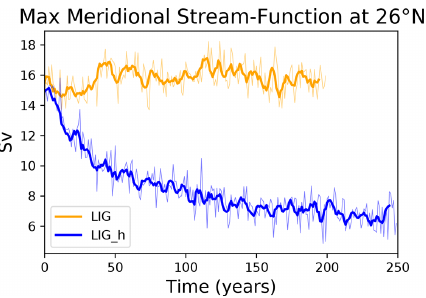
Figure 1. Maximum meridional streamfunction at 26 ◦ N for LIG (orange) and LIG_hosing (blue). Thin lines are annual means, thick lines are 11-year running means.